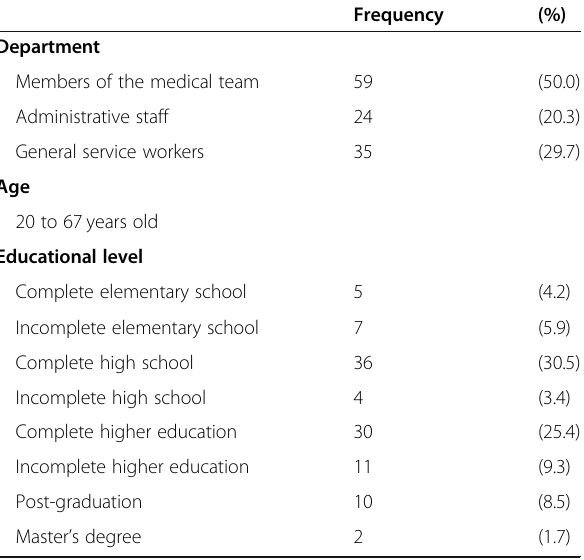
Table 1 Sociodemographic characterization of the sample ( N = 118 professionals)